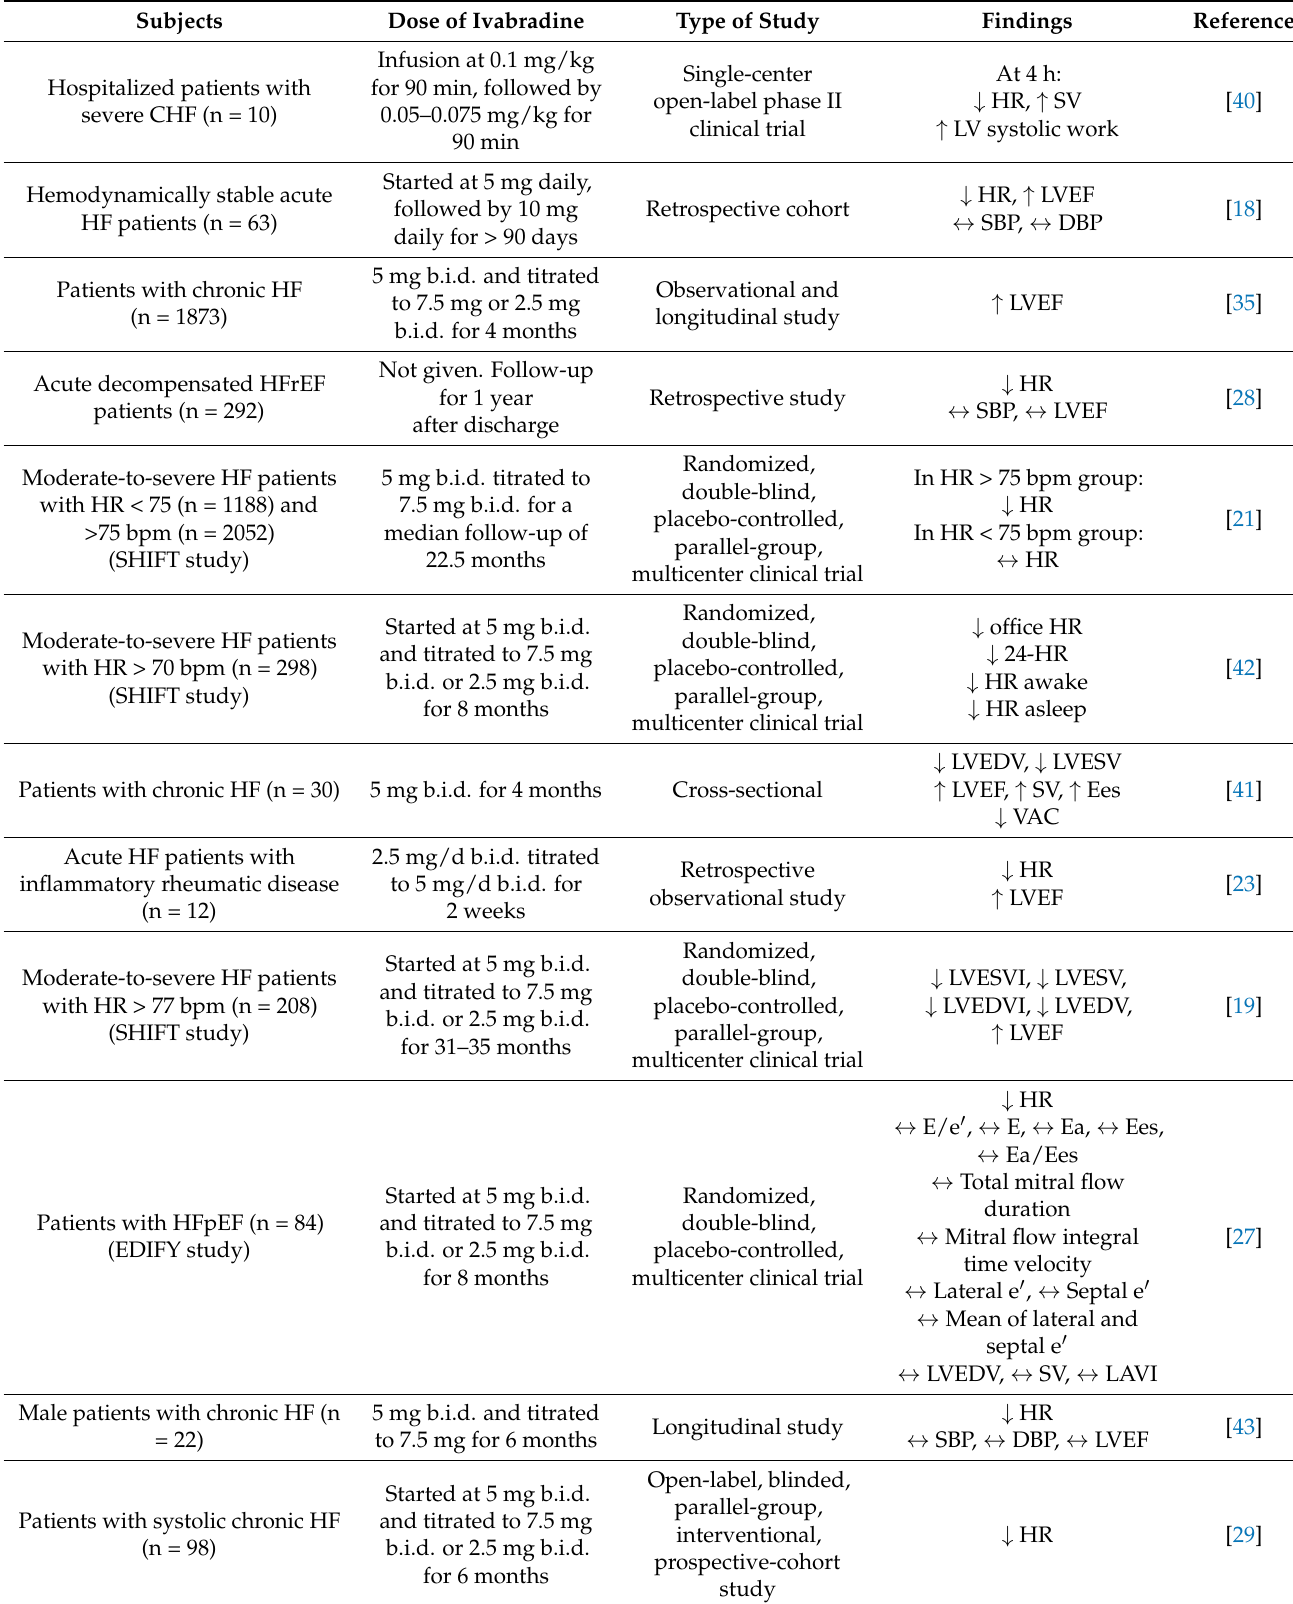
Table 2. Effects of ivabradine on cardiac function in human